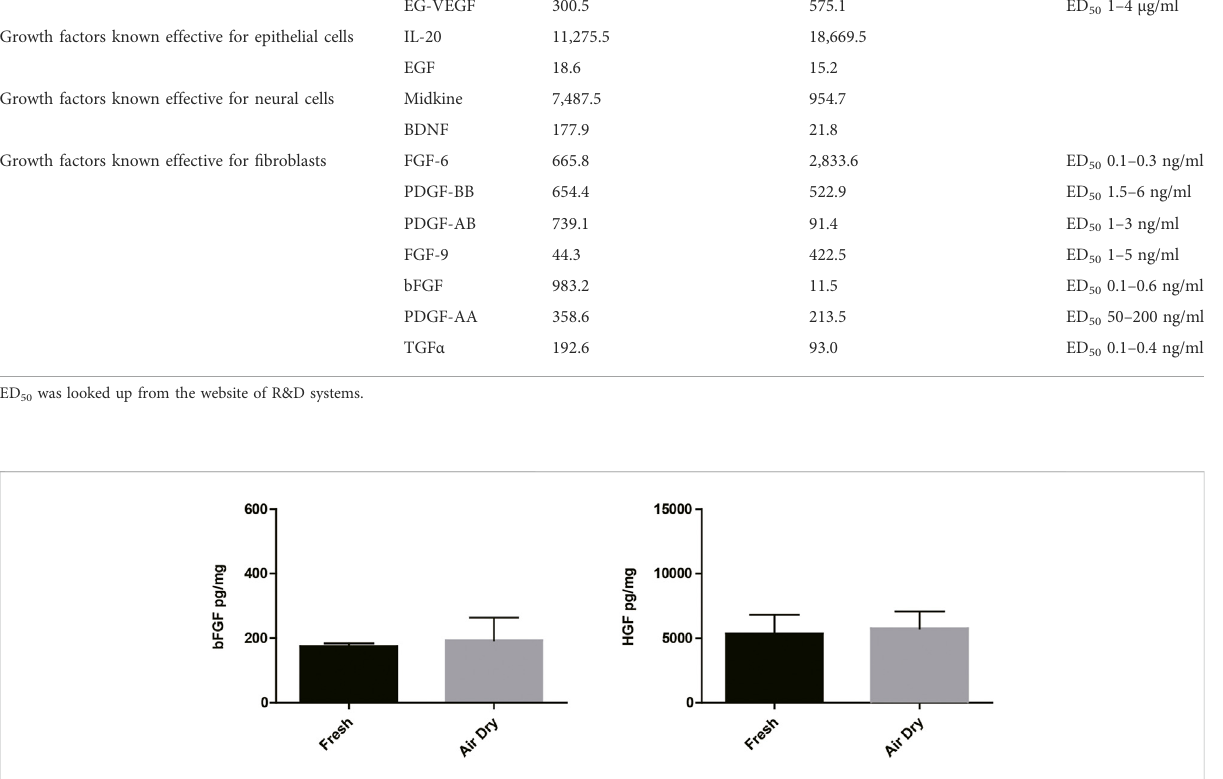
FIGURE 2 bFGF and HGF testing results of the air-dry-derived amnion/chorion complex and fresh tissues. The air-dry procedure maintained similar content of bFGF and HGF growth factors compared with the fresh tissues. Data represent mean ± SD and n = 3 biological repeats for each group. Student ’ s t-test was used for statistical analysis, and data were not signi fi cantly different for each